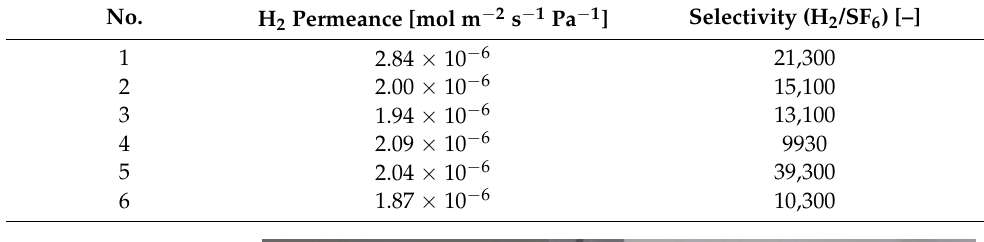
Table 1. Hydrogen permselective performances of silica membranes for membrane reactor module.